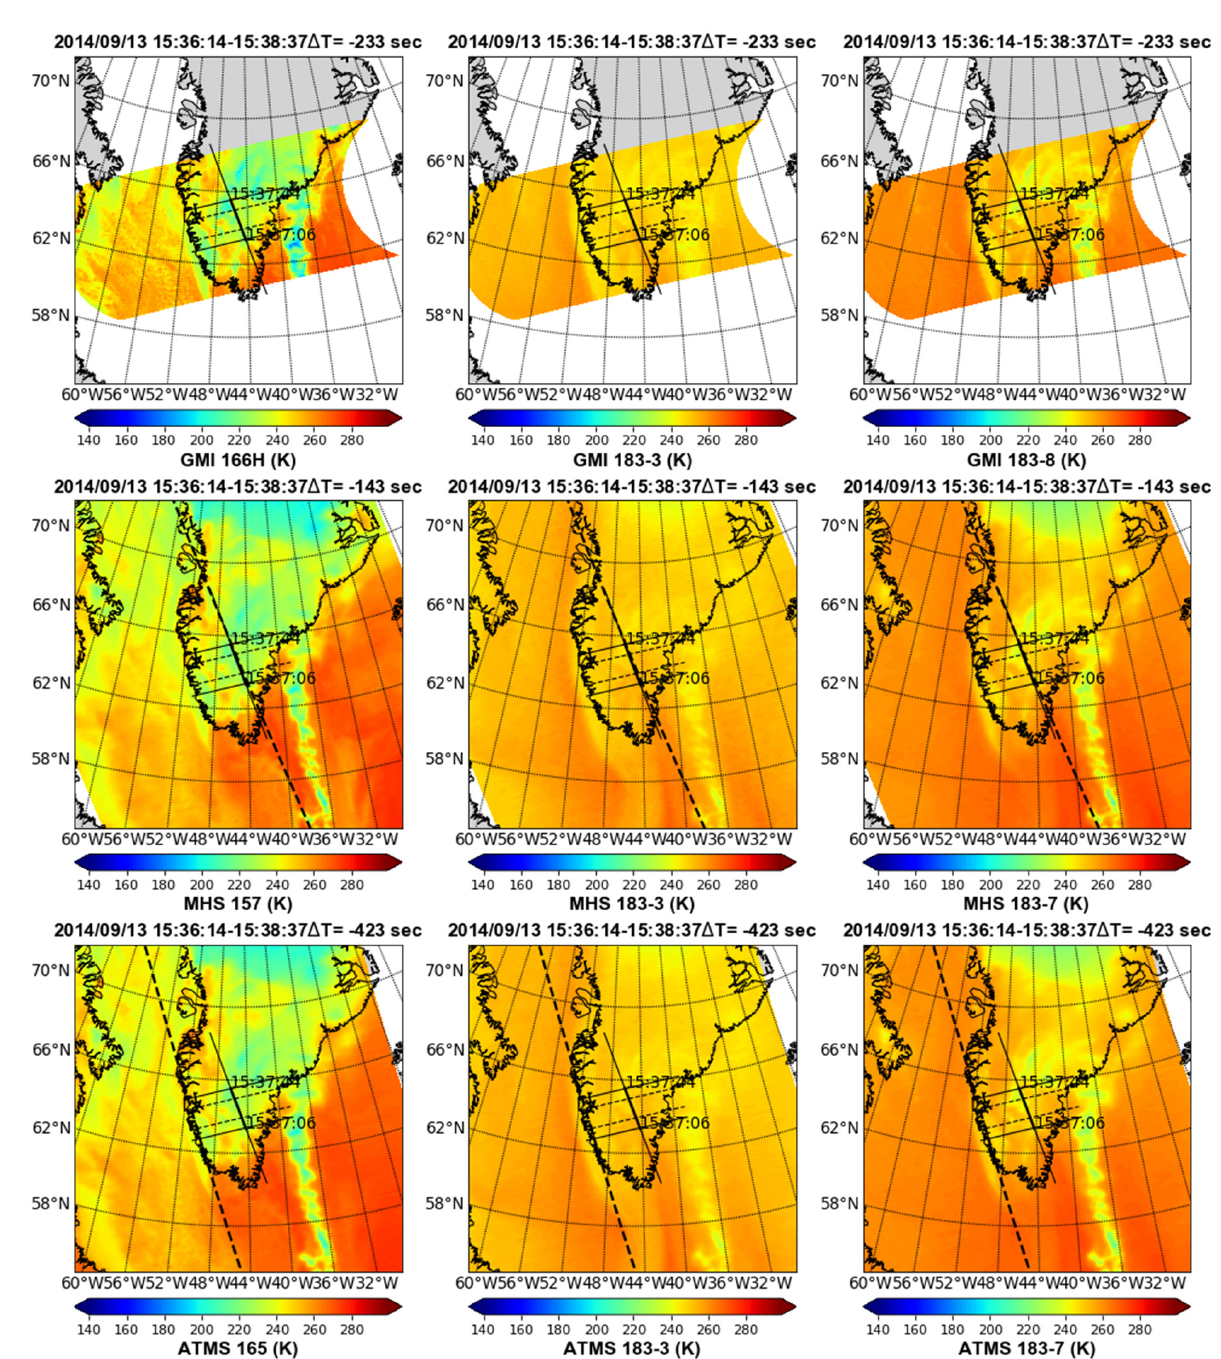
Figure 5. A depiction of a high-latitude CloudSat-GPM coincidence on 13 September 2014 between 1536 and 1538 UTC, located near the southern tip of Greenland. In this instance, both the NOAA-19 and Suomi-NPP overpass occurred within 143 and 423 s of the CloudSat-GPM coincidence time, respectively. ( Top row ) Three channels from GMI (166H, 183.31 ± 3 and 183.31 ± 8 GHz). ( Middle row ) The corresponding channels from MHS on NOAA-19 (157, 183.31 ± 3 and 190.31 GHz). ( Lower row ) The corresponding channels from ATMS on Suomi-NPP (165, 183.31 ± 3 and 183.31 ± 7 GHz).